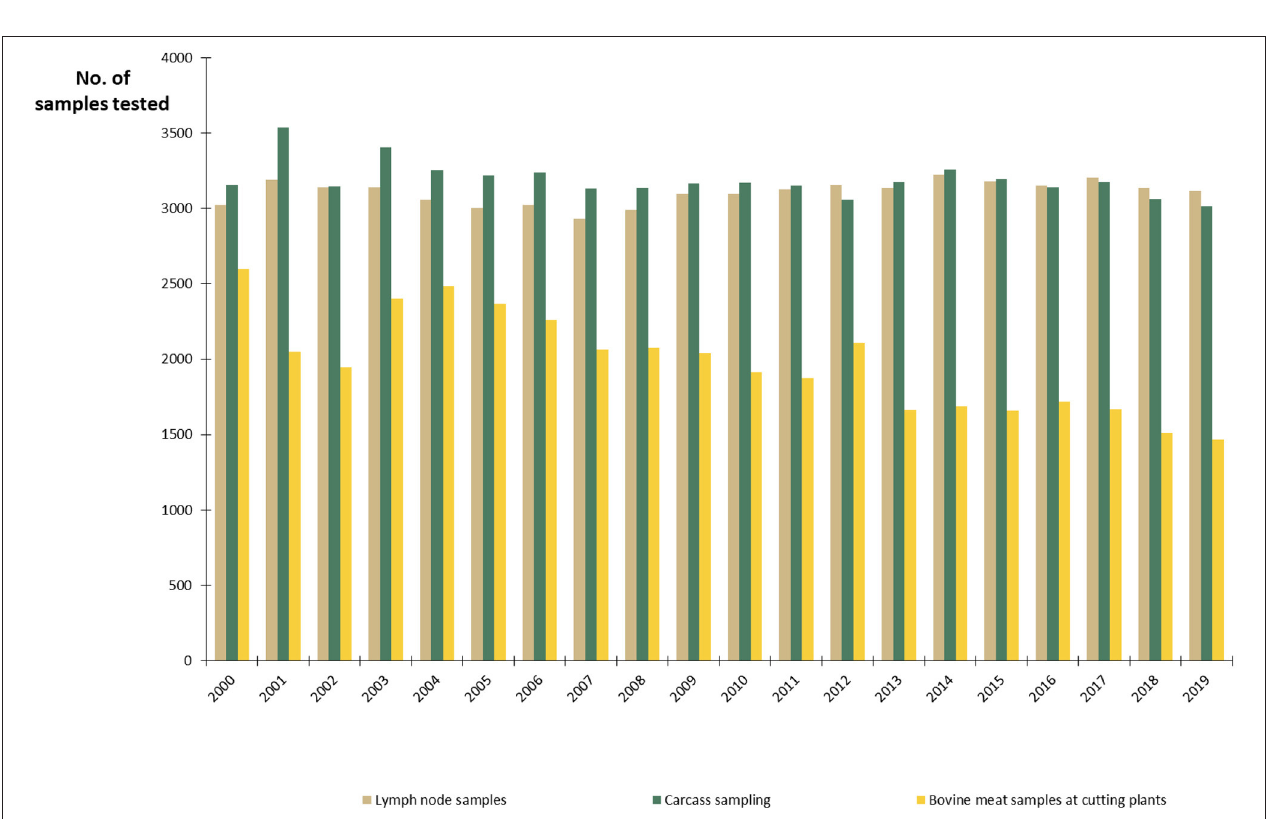
FIGURE 5 | Number of samples from slaughterhouses and meat cutting plants annually tested for Salmonella in the control program in Finland in 2000–2019.